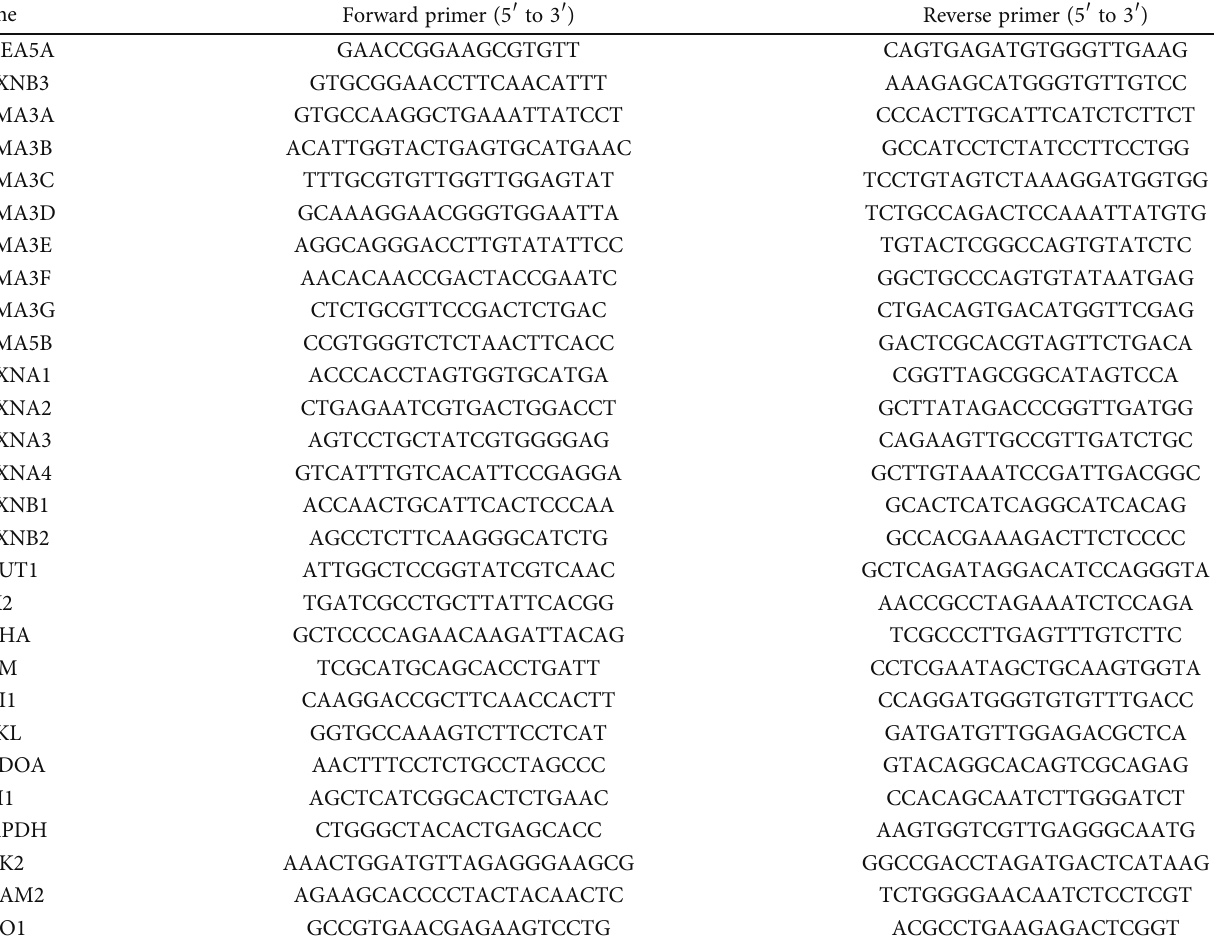
Table 1: Primer sequences used for